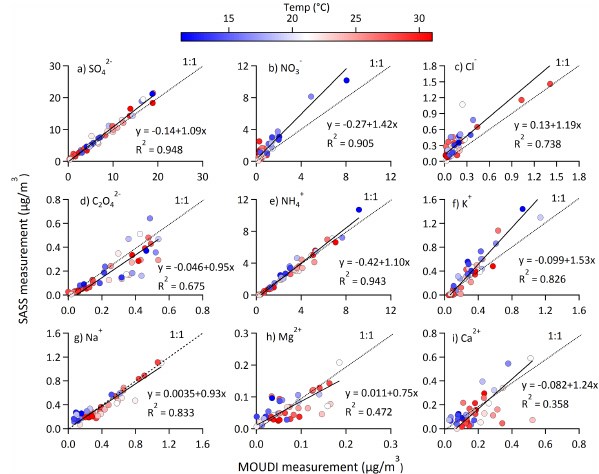
Figure 1. Comparison between MOUDI measurements (<3.2µm) and PM 2 . 5 measurements with the SASS sampler. Orthogonal dis- tance regression is applied to examine the comparison. Data points are color-coded by ambient temperatures on the individual sampling days. A segregation of data points by temperature was observed for nitrate; see text for